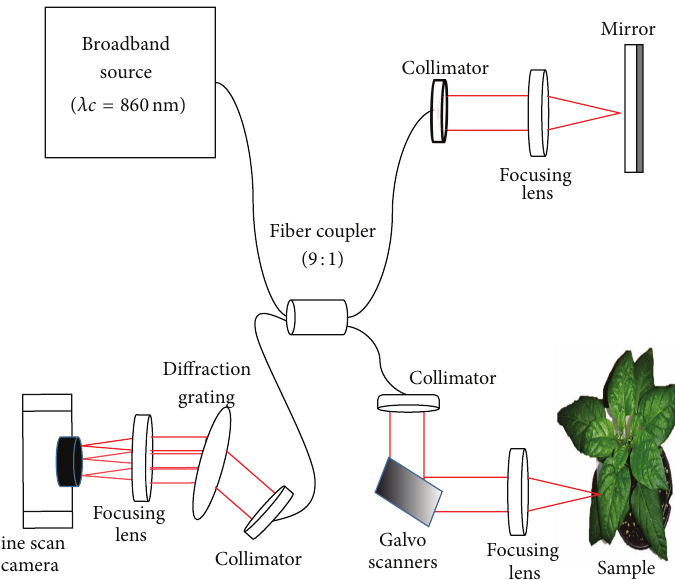
Figure 1: Schematic diagram of the SD-OCT